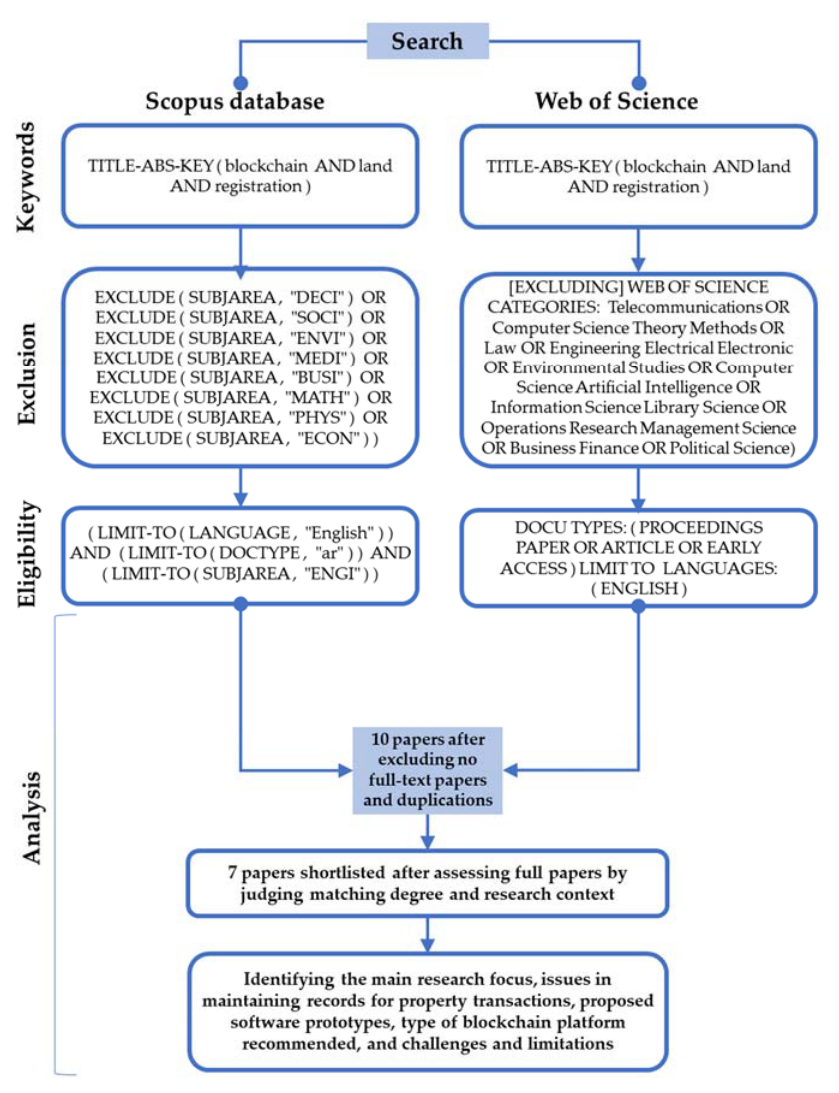
Figure 2. The search strategy.